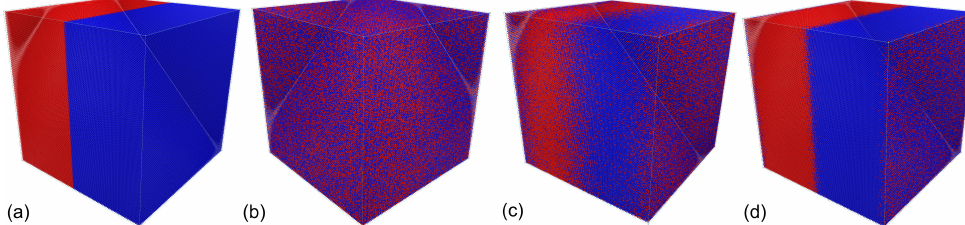
Figure 6. Example of simulation snapshots for ( a ) t = 0, ( b ) ε AB /2 k B T = 0 and t = 10 5 , ( c ) ε AB /2 k B T = 0.1 and t = 10 5 , and ( d ) ε AB /2 k B T = 0.5 and t = 10 6 . Types A and B are marked with different